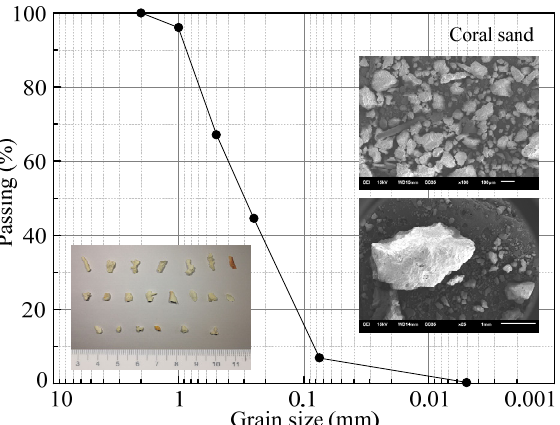
Figure 1. Particle distribution curve, photograph and scanning electron microscope picture (SEM) of tested coral sand.